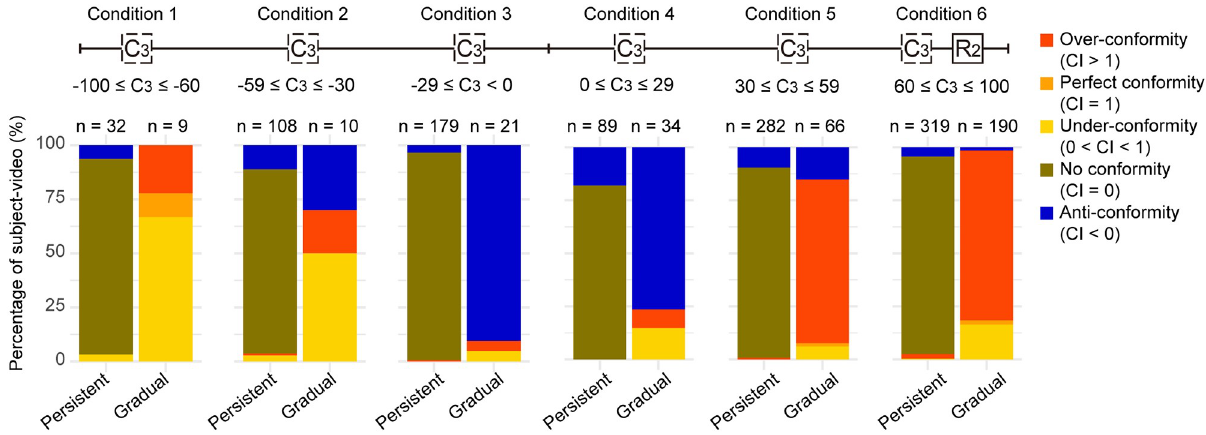
Fig 7. Conforming bebaviours of highly-confident participants in confederate session 3. The percentage of conforming behaviour (CI as colour bars) in session 3 for participants who have reached high R 2 confidence (i.e., when 60 � R � 100), either gradually (i.e., R 0 is not high, and R 0 < R 1 < R 2 ) or persistently (i.e., participants remain highly confident from the beginning). Participants’ reactions are further classified by the C 3 they saw (relative to R 2 ) (see symbols on top). One participant (participant #32) who did not change his/her confidence for all 3 sessions in all questions (i.e., with mean of CI and S.D. of CI = 0, see S6 Fig) was excluded from analysis to better capture the behaviour of responsive